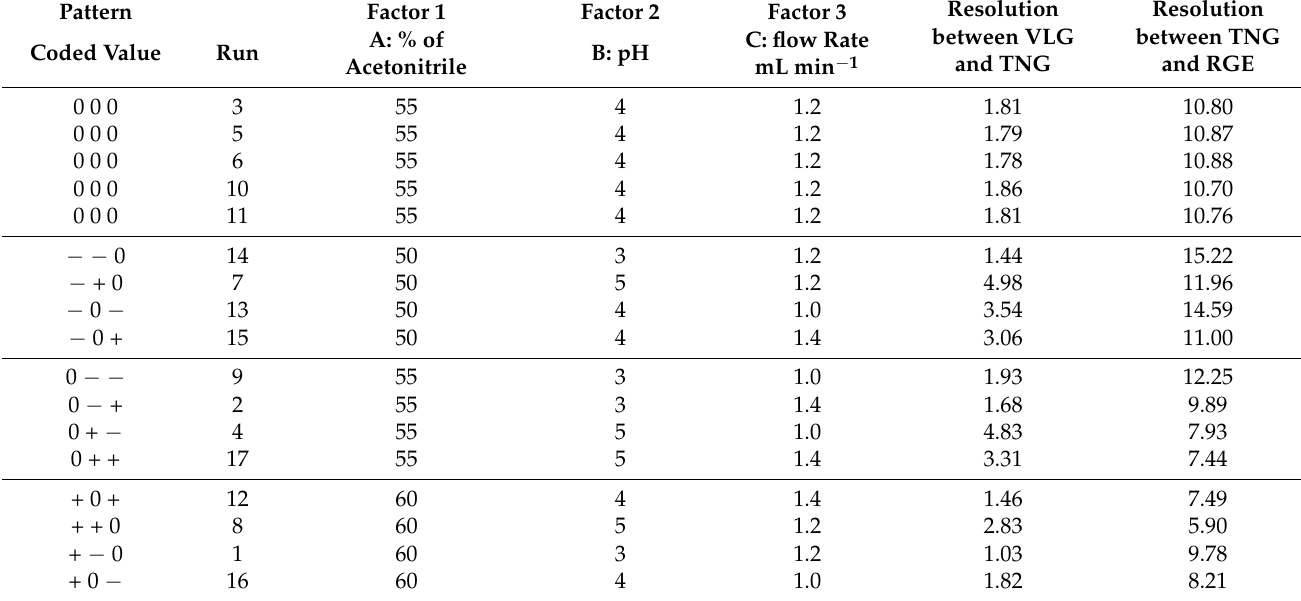
Table 1. Seventeen experiments suggested by BBD for optimization of chromatographic